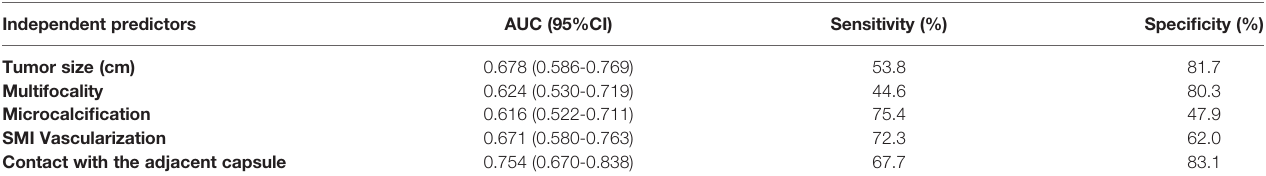
TABLE 4 | Predictive value analysis of CLNM of PTCs.